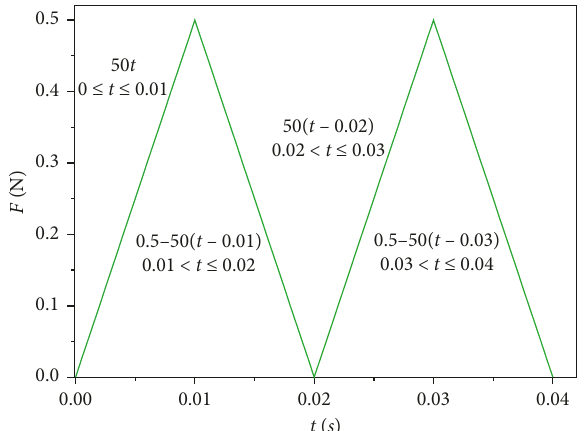
Figure 14: Triangular wave load.